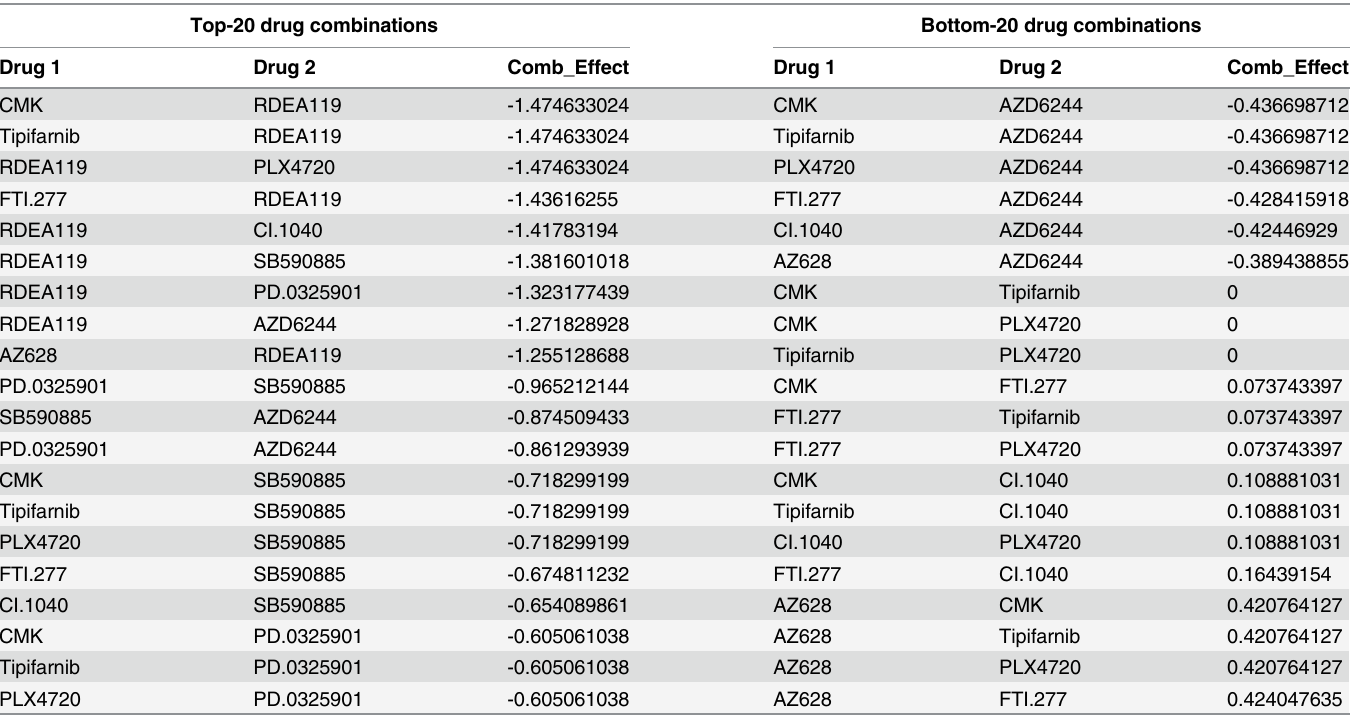
Table 3. Drug combination effects for 647-V cell line. Top-20 drug